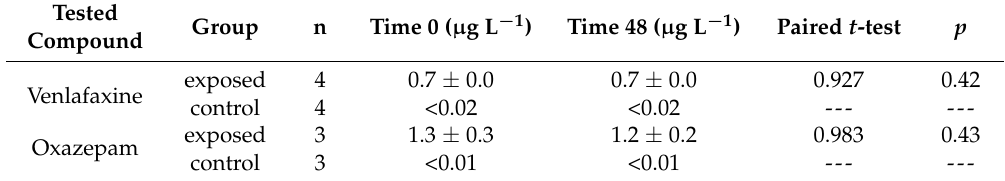
Table 2. The concentration of VEN and OXA in the water at time 0 (control, exposed) and after 48 h of exposure (control, exposed) ( α = 0.05). Data are presented as mean ± standard